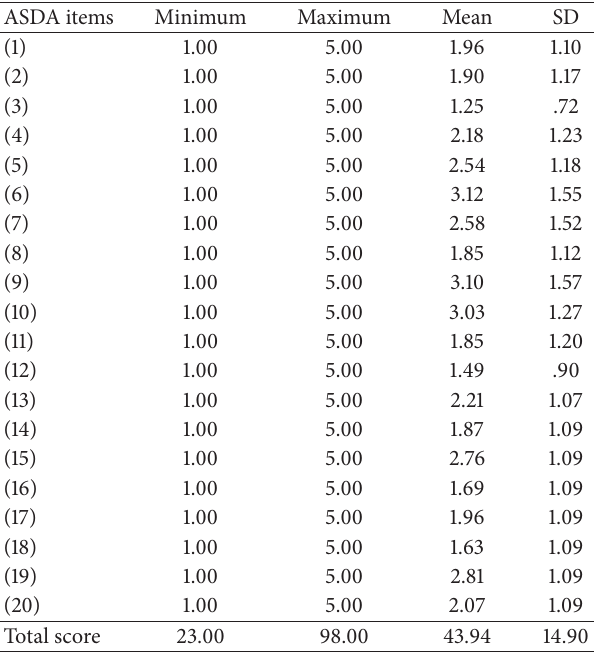
Table 1: Mean and SD of the ASDA items and total